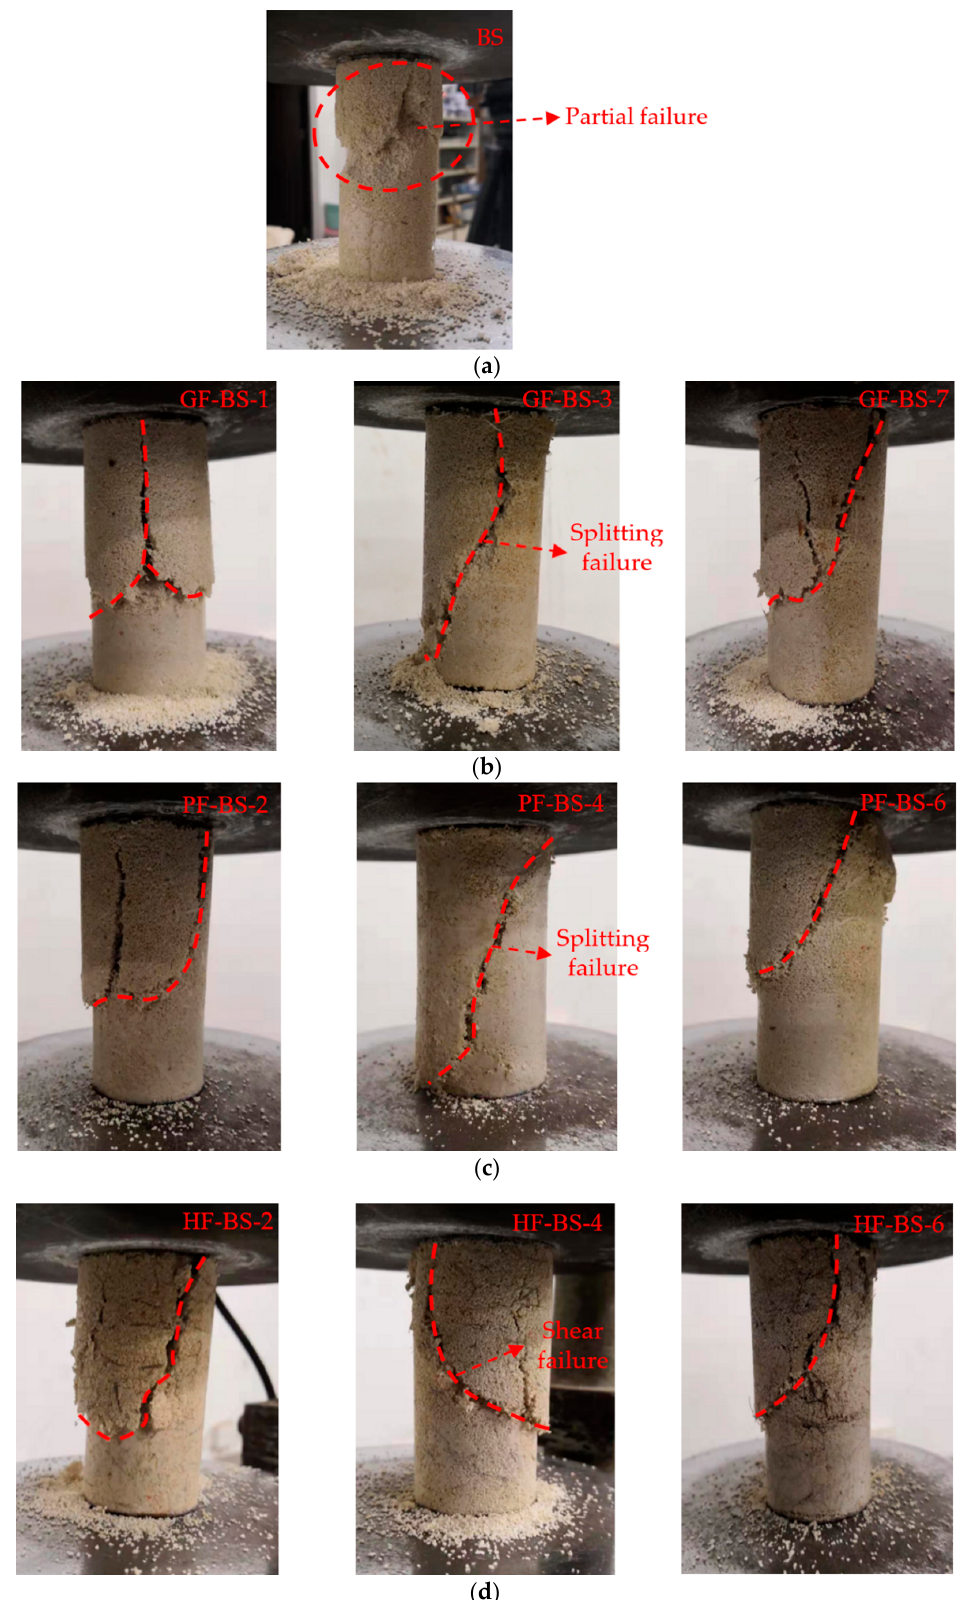
Figure 11. Failure pattern of biocemented sand under different fiber types and contents, ( a ) Failure pattern of the BS; ( b ) Failure pattern of biocemented sand under different glass fiber contents; ( c ) Failure pattern of biocemented sand under different polyester fiber contents; ( d ) Failure pattern of biocemented sand under different hemp fiber contents.